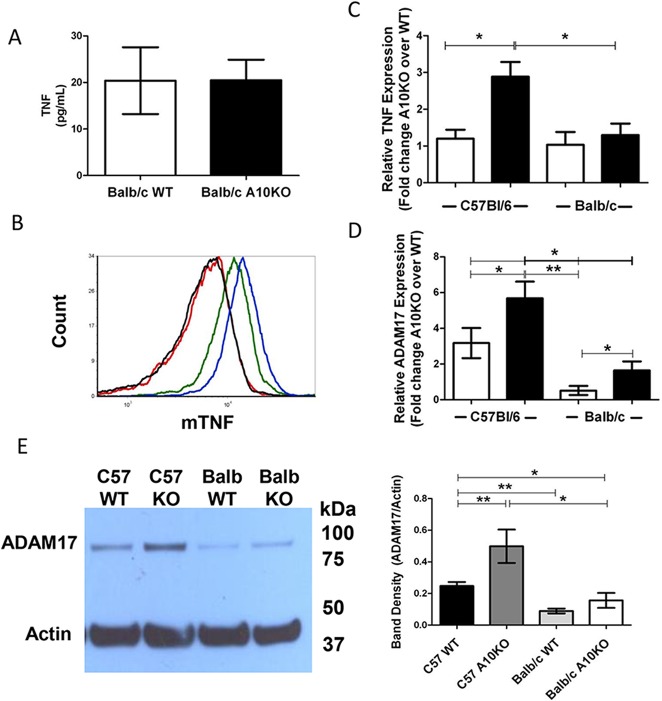
B cell TNF and ADAM17 regulation in C57Bl/6 and Balb/c ADAM10B-/- (A10K0) and WT.(A) sTNF or (B) mTNF from 3 day stimulated (LPS + IL4) B cell cultures; (B) Balb/c WT (black), Balb/c A10KO (red), C57Bl/6 WT (green), and C57Bl/6 A10KO (blue) B cells. (C) Fold change (A10KO over WT) in relative TNF message from naïve (white) or 3 day stimulated (anti-CD40+IL4) (black) B cells normalized to 18s. (D) Fold change (A10KO over WT) in relative ADAM17 expression normalized to 18s for naïve (white) or 3 day stimulated (black) B cells. (C,D) * signifies ≥2 fold change between groups. (E) ADAM17 (~93kDa) and actin (~42kDa) from 5 day stimulated (anti-CD40 + IL4) B cells (left) and band densitometry (right). KO = A10KO. n = 9 per group, 3 independent studies. *p<0.05, **p<0.005.